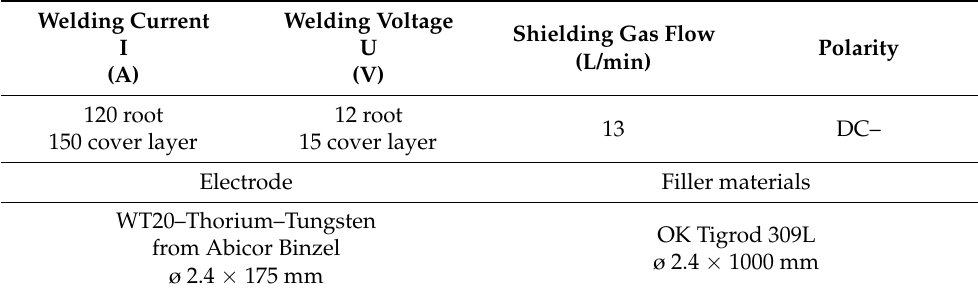
Table 3. Used parameters of hammer welding.